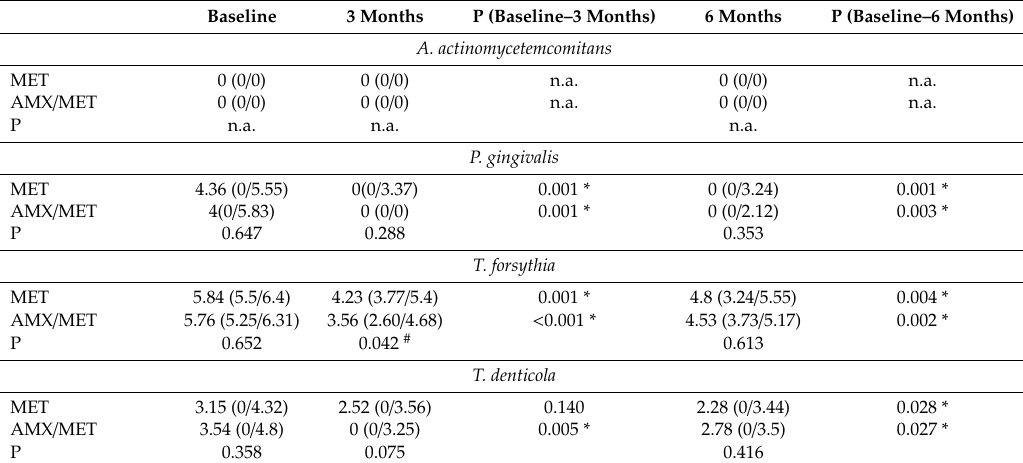
Table 3. Bacterial counts (log10, median, 25 percentile, 75 percentile) / sample of Aggregatibacter actinomycetemcomitans , Porphyromonas gingivalis , Treponema denticola and Tannerella forsythia at baseline, after three and six months in the MET (subgingival instrumentation + metronidazole) and the AMX / MET groups (subgingival instrumentation + metronidazole / amoxicillin).